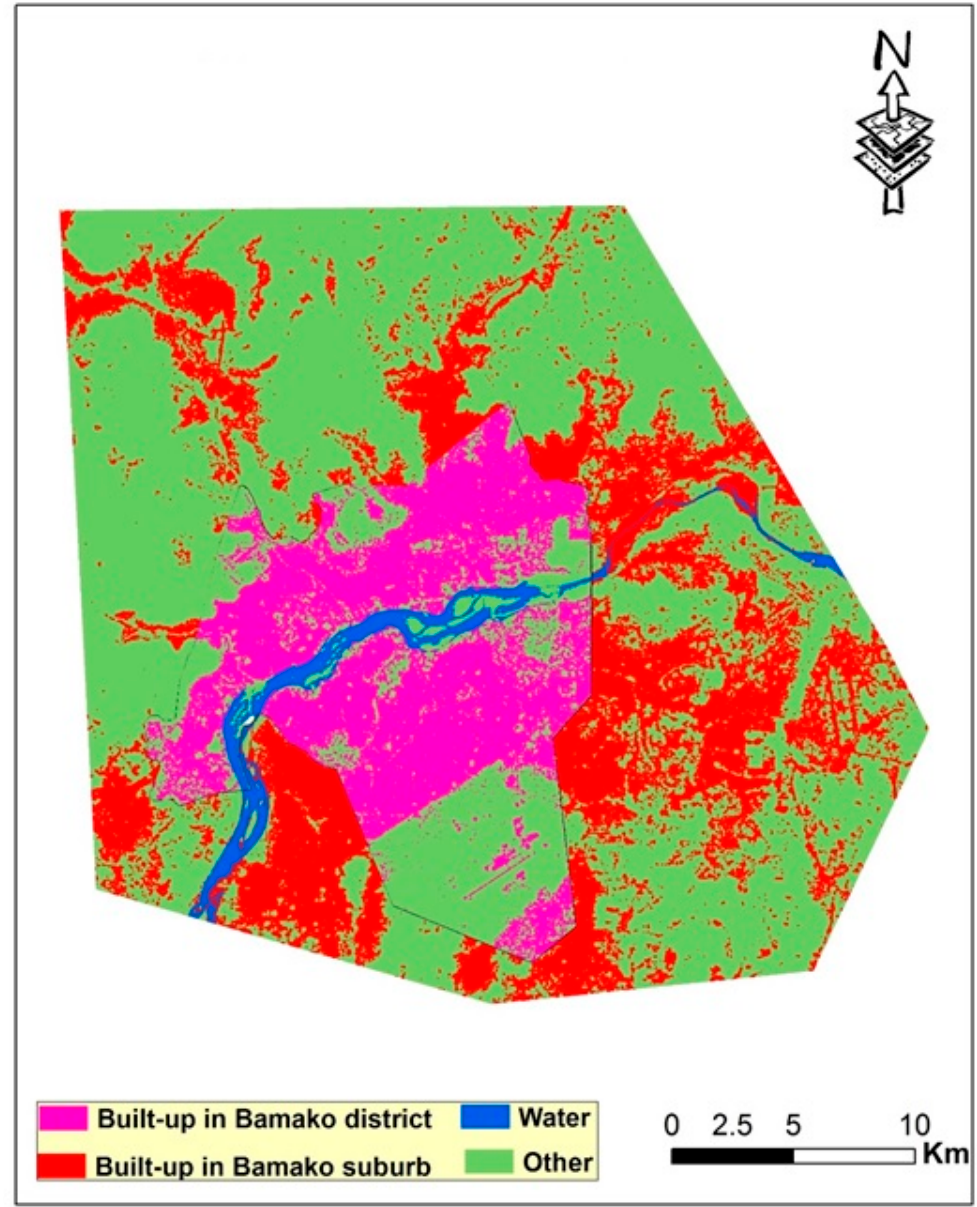
Figure 4. Urban sprawl status in Bamako district and its suburbs areas in 2018.